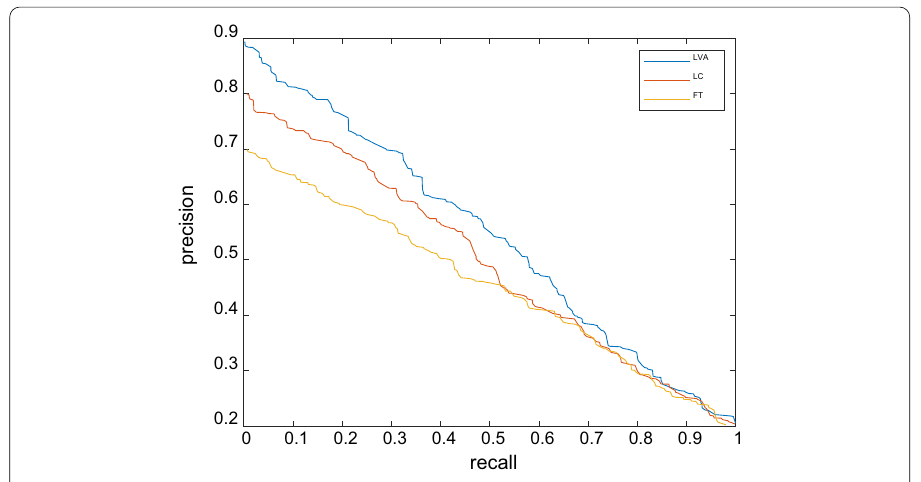
Fig. 5 PR curves of the three